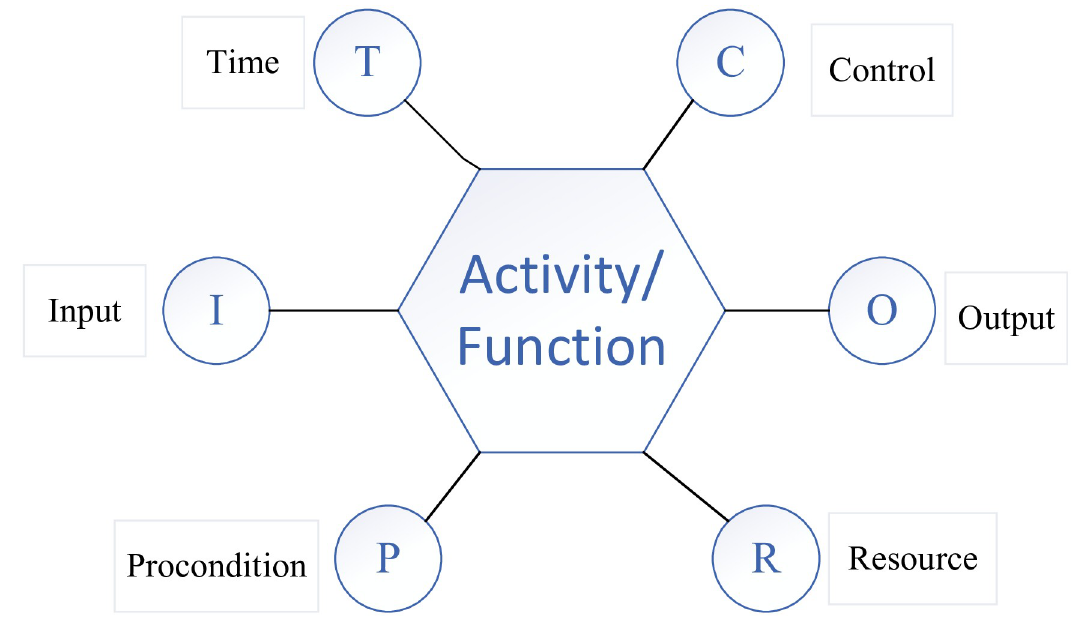
Fig 2. Function identification and